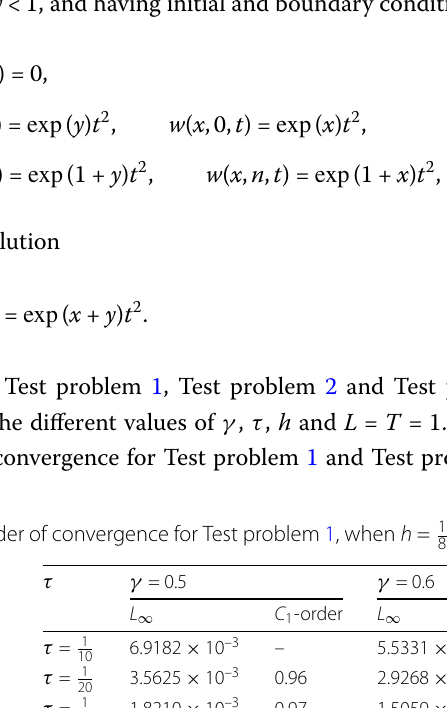
Table 1 C 1 -order of convergence for Test problem 1, when h = 1 τ γ =